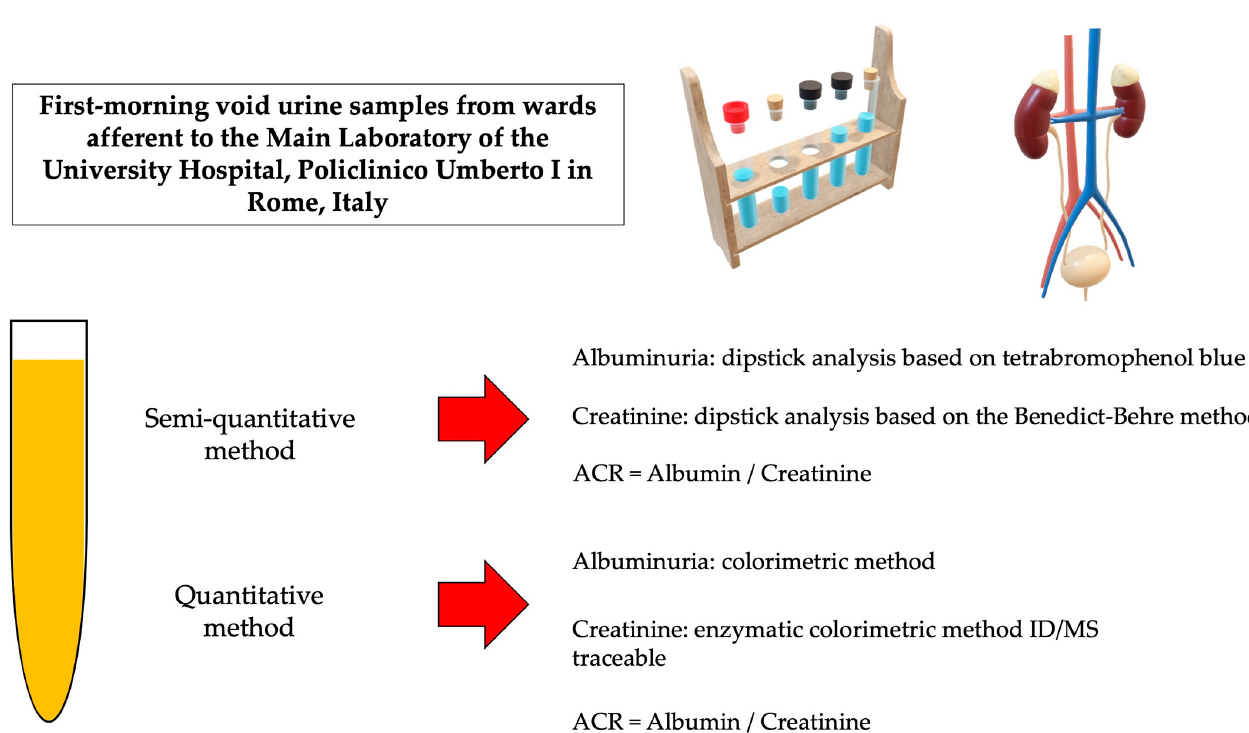
Figure 1. Sample preparation diagram. We aimed to compare two different diagnostic methods to evaluate kidney damage. From November 2020 to January 2021, we selected 249 sequential subjects of various ages and genders whose first morning void was analyzed at the Core Laboratory of the Policlinico Umberto I University Hospital in Rome. An initial semi-quantitative analysis was performed, followed by a quantitative test. Albumin was evaluated by dipstick analysis (Meditape UC-11A, Sysmex Corporation HQ: Kobe, Japan) based on a PH indicator (tetrabromophenol blue). The creatinine analysis was based on the Benedict-Behre method. The ACR, albumin creatinine ratio was calculated using the Sysmex UC-3500 Automatic Urine Analyzer’s semi-quantitative method. Quantitative analysis of albumin, creatinine, and total urinary protein were performed on a Cobas C 501 analyzer (Roche Diagnostics GmBH, Mannheim, Germany). Albumin was measured using a colorimetric method, creatinine by an enzymatic colorimetric method, and urinary proteins by a turbidimetric method. The ACR was calculated. Images have been created using the functionalities of Microsoft PowerPoint 365 Version 2112. https://www.microsoft.com/microsoft-365. Used with permission from Microsoft. Accessed on 13 March 2023.